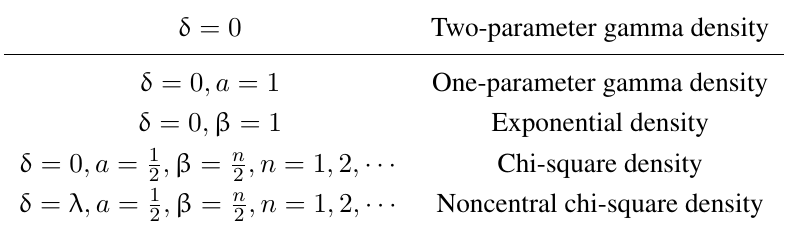
Table 1. Special cases of the generalized gamma model associated with the Bessel